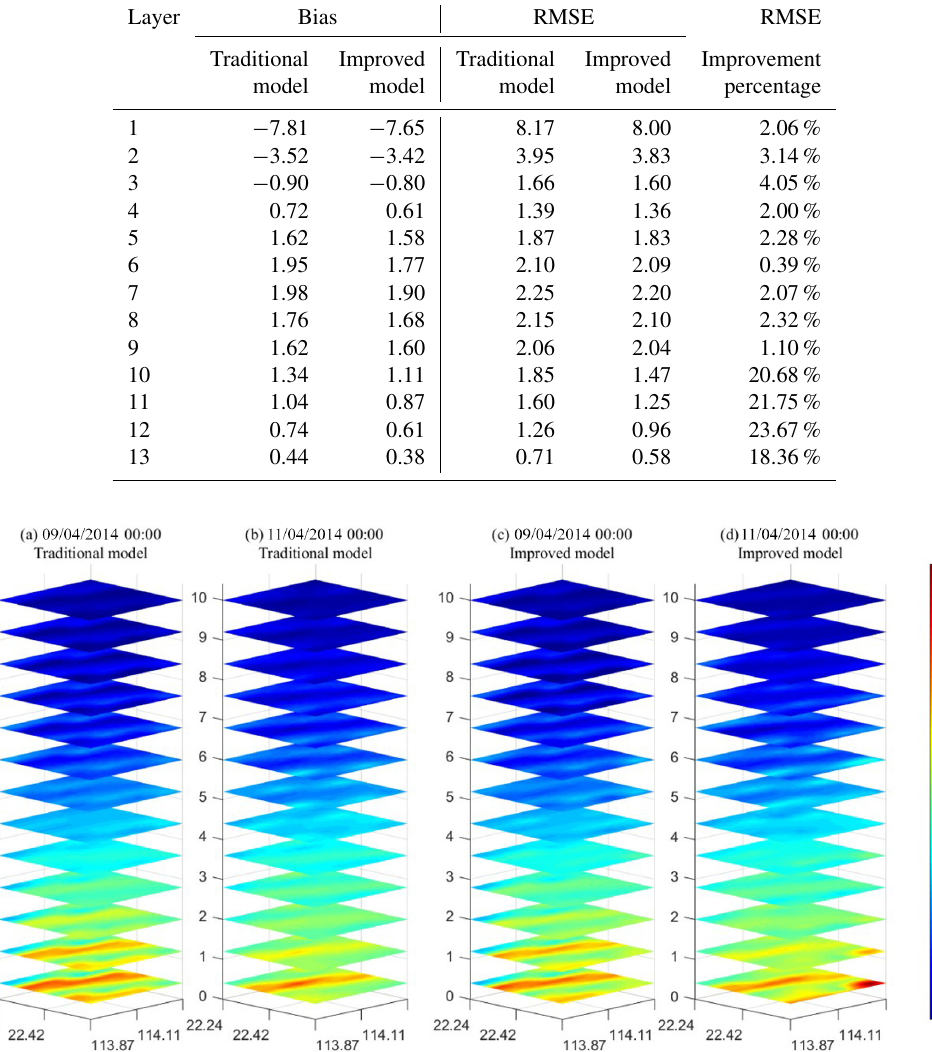
Figure 2. The layered maps of the water vapor density from (a, b) the traditional model and (c, d) the improved model at specific epochs, (a, c) 00:00UTC on 9 April 2014 and (b, d) 00:00UTC on 11 April 2014.